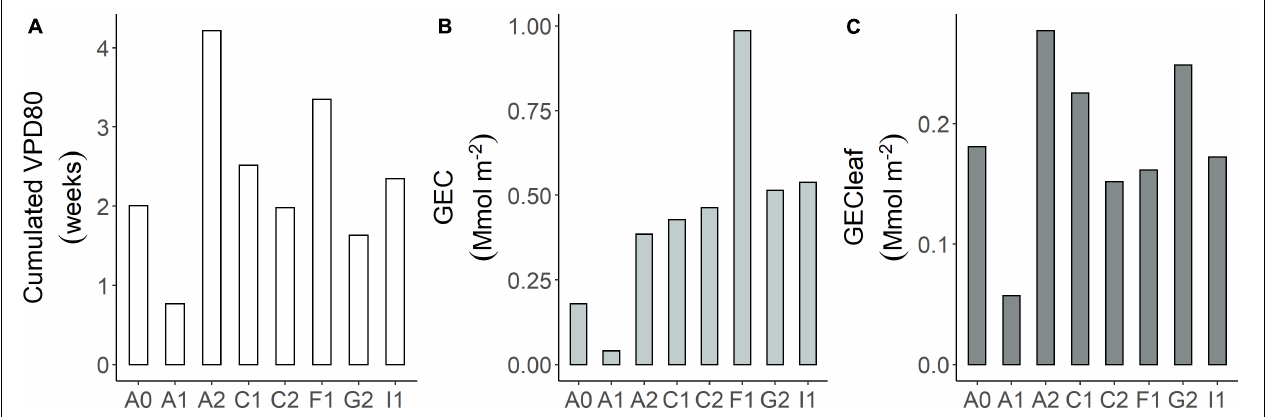
FIGURE 5 | (A) Cumulated VPD 80 expressed as weeks per site during the main growing season. As the growing season, we considered the period from May to August in the northern hemisphere and from November to February in the southern; maximum gas exchange capacity (GEC) per site: (B) GEC = n.VPD 80 × G surf ; (C) GEC leaf = n.VPD 80 × G surf per unit of leaf